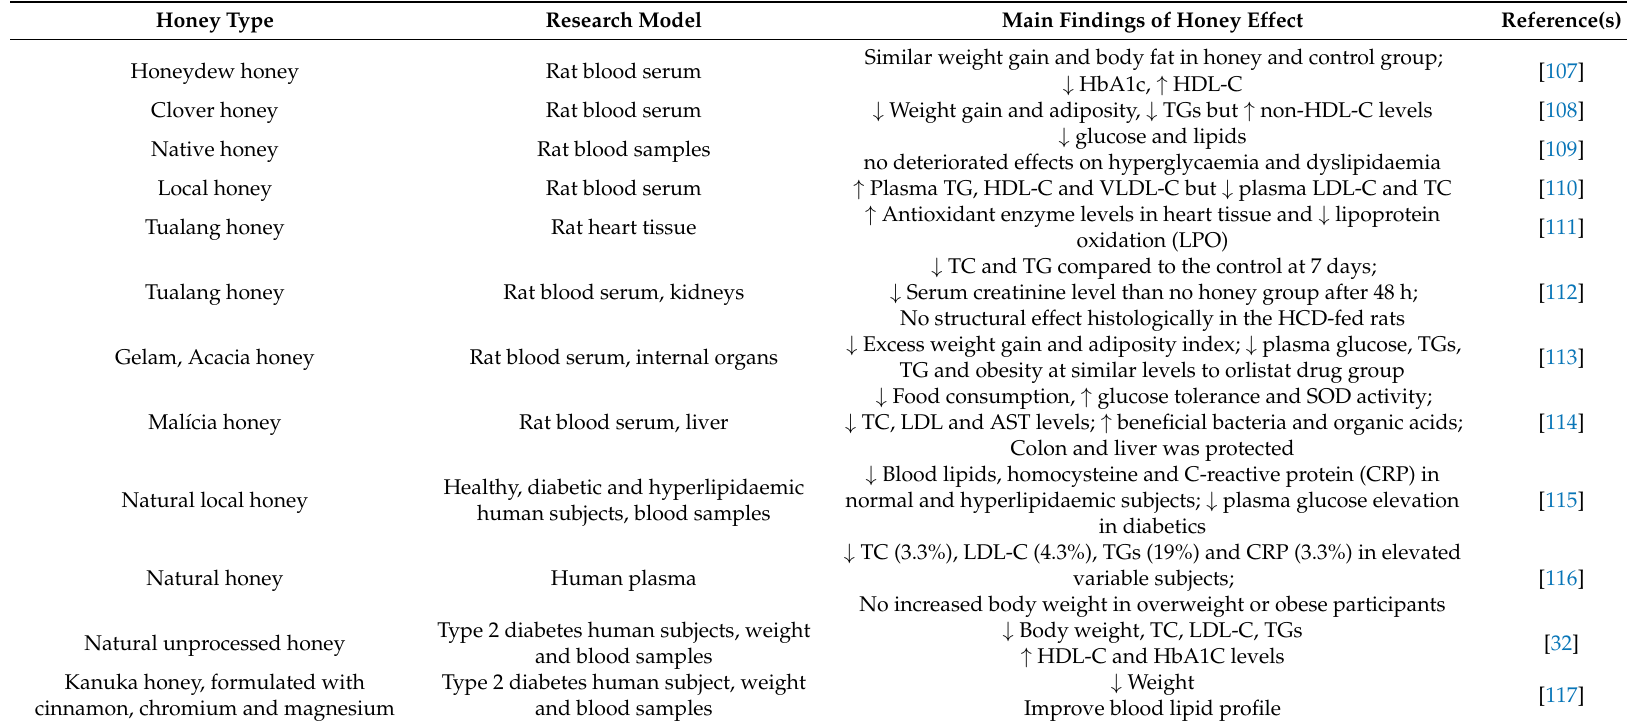
Table 4. Effects of honey on lipid